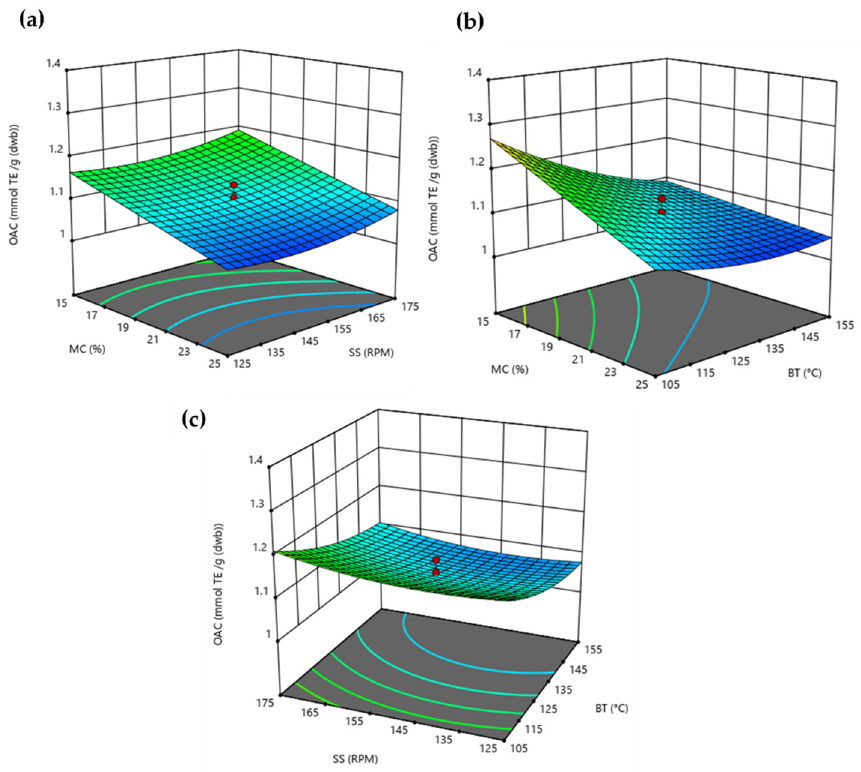
Figure 3. Response surface plots showing the effects of ( a ) moisture content (MC) and screw speed (SS), ( b ) moisture content (MC) and barrel temperature (BT), and ( c ) barrel temperature (BT) and screw speed (SS) on overall antioxidant content (OAC).